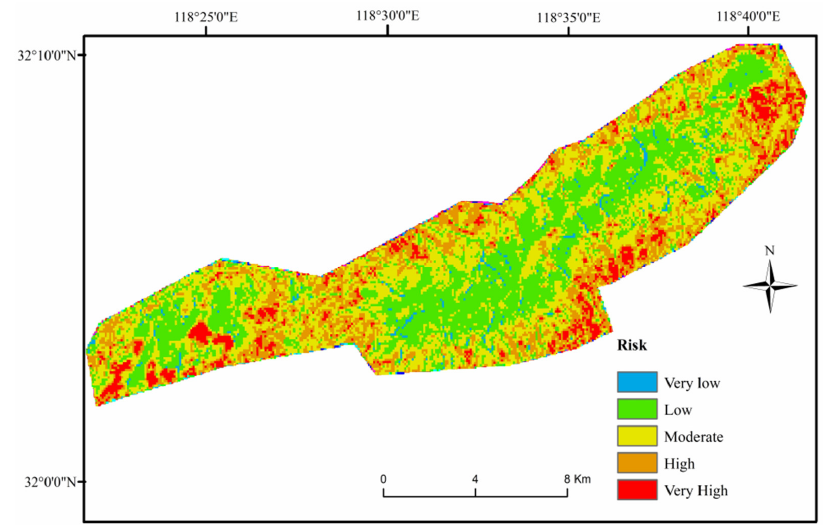
Figure 2. Forest fire risk map of study area.